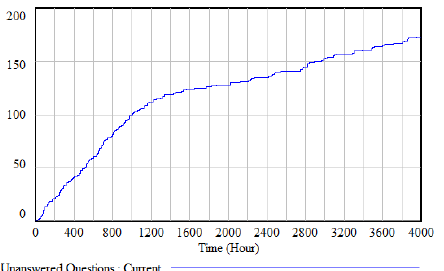
Fig. 4. The trend for unanswered questions